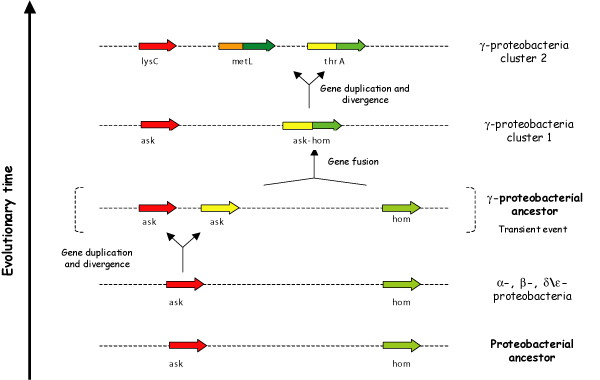
The evolutionary model. Evolutionary model proposed to explain the evolution of ask and hom genes in proteobacteria.